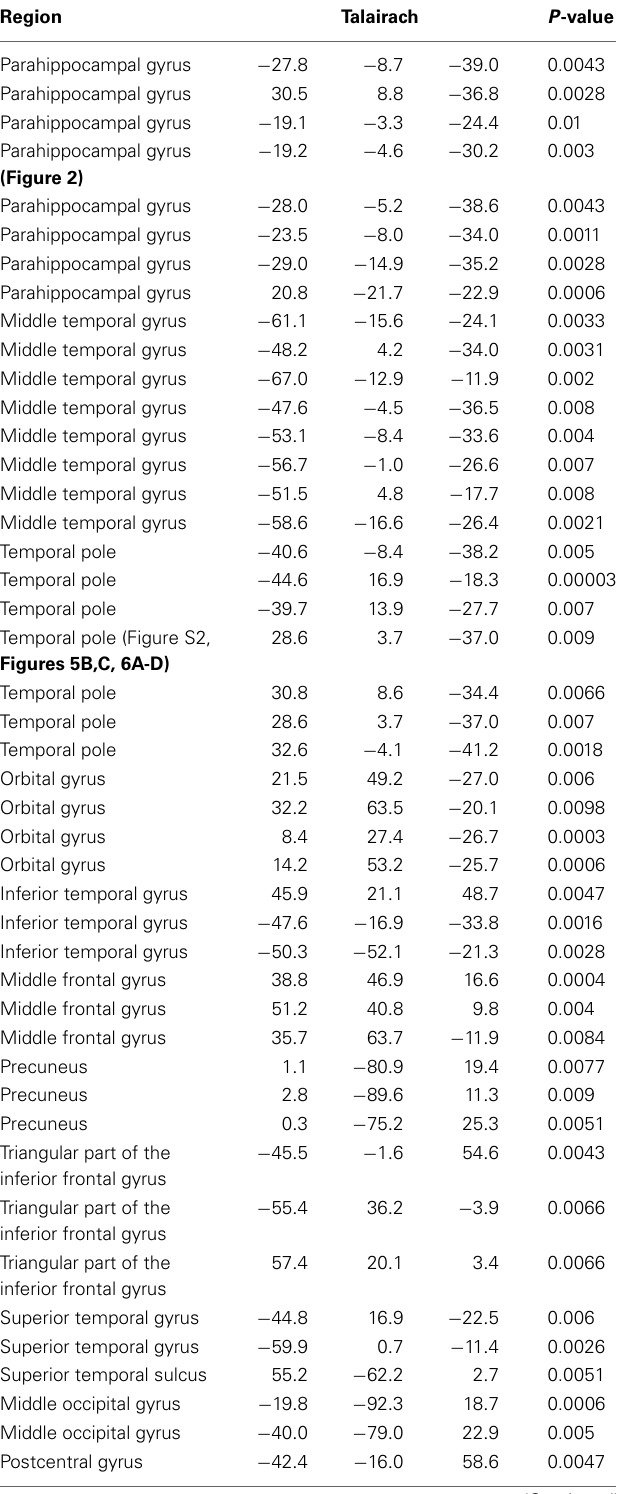
Table 2 | Location and statistics of 51 electrodes that showed significant ( p < 0 . 01, rank sum test) changes in gamma band amplitudes with learning ( N = 11 subjects that learned Task 1 and